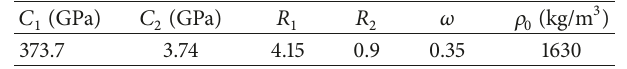
Table 2: JWL constants of